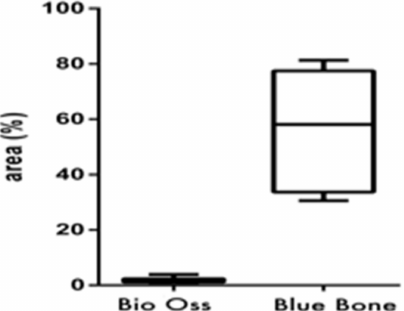
Figure 6. (Graphic 2) Histomorphometric analysis of PAS staining showed higher polysaccharides, glycoproteins, and glycolipid content in Group 2 (nano-hydroxyapatite / beta-tricalcium phosphate composite) than Group 1 (bone xenograft). A statistical di ff erence was also found between Group 1 (bone xenograft) and Group 2 (nano-hydroxyapatite / beta-tricalcium phosphate composite), ( p =